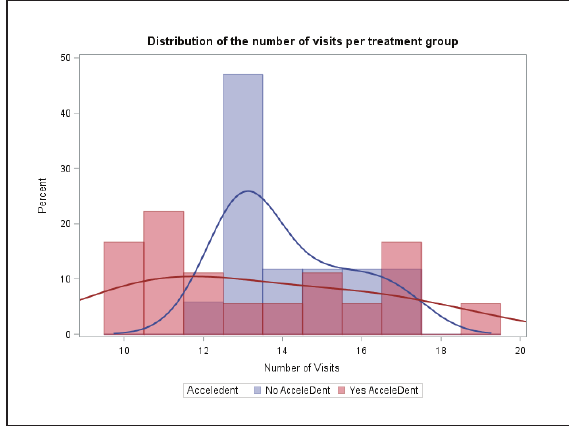
Figure 3. Histogram of the number of visits for the AcceleDent and control groups demonstrating a larger spread in the number of visits for AcceleDent.